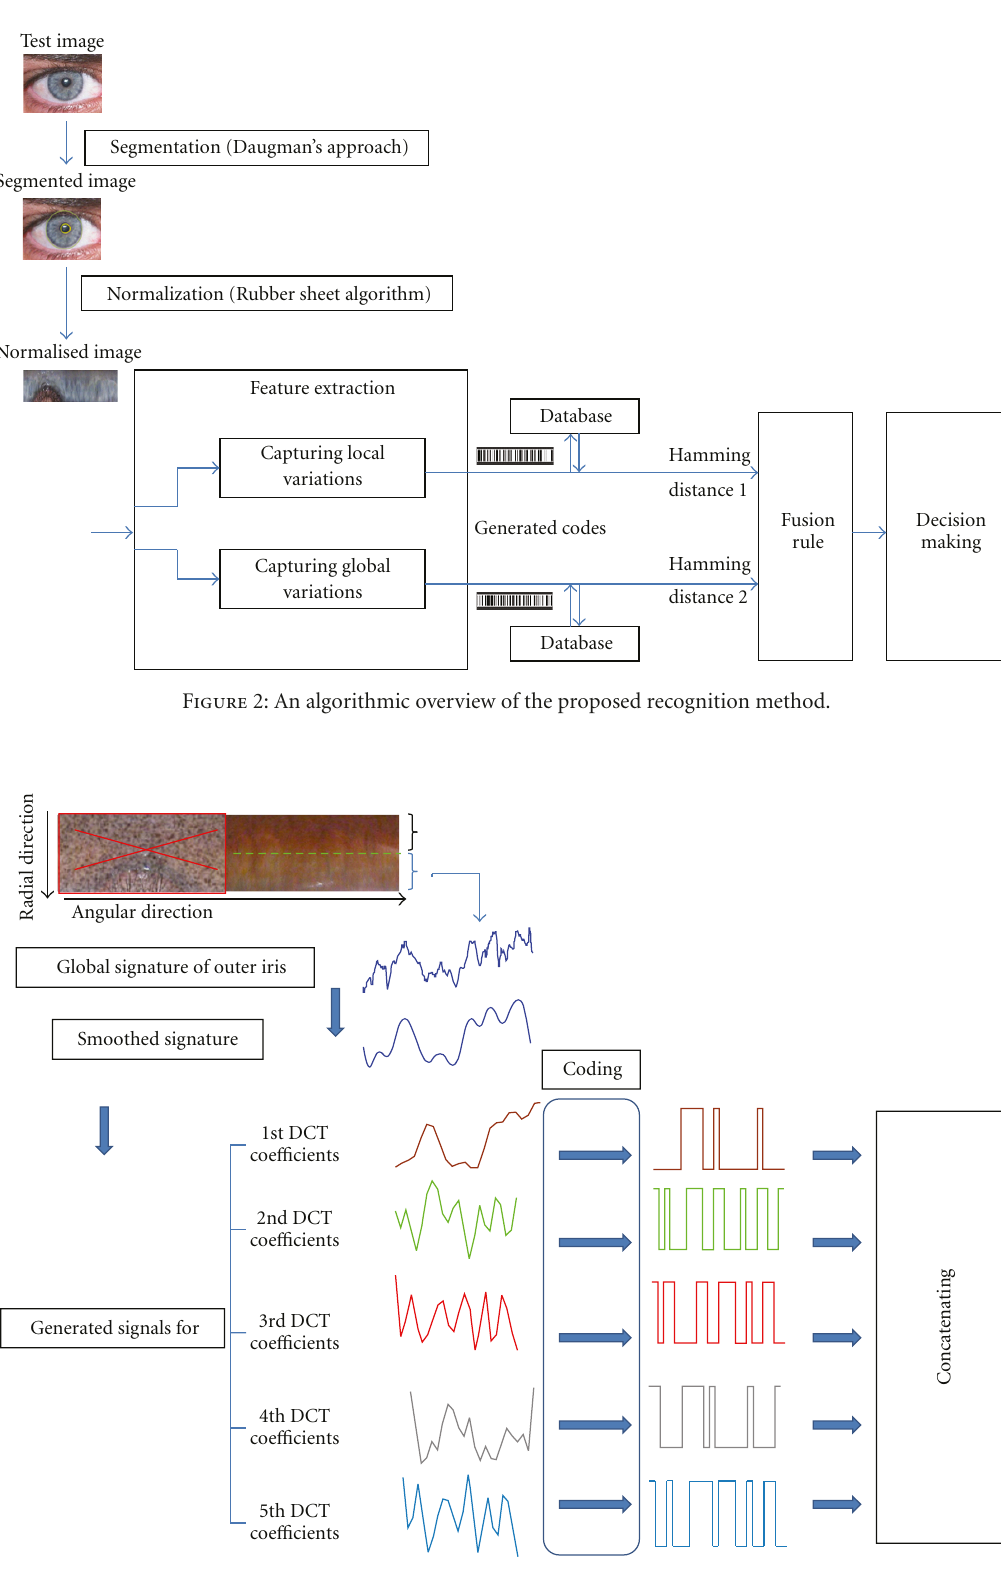
Figure 3: An overview of the proposed method for extracting global texture variations. The green dashed line separates the region of interest into two subregions which for each the global feature extraction is performed. The red cross indicates the omission of the left half of the normalized image corresponding with the upper half of the iris which is often occluded by the eyelids and eyelashes. Note that, in the case of NIR images, the upper half of the iris is not